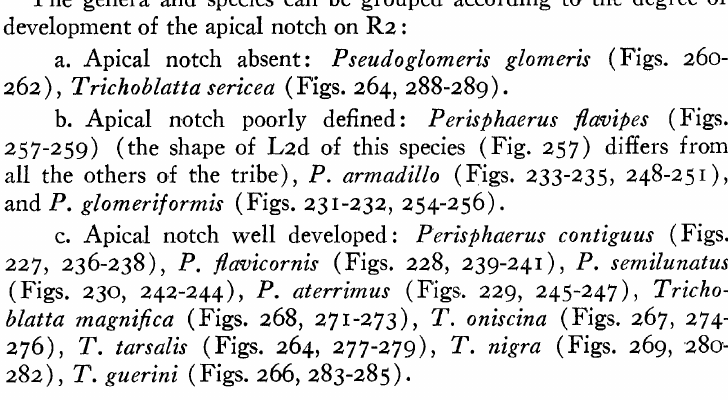
(Figs. :z3o, :z4:z-:z44), P. aterrimus (Figs.. :z:z9, :z45-:z47), Tricho- blatta magnifica (Figs. :68, :7I-:Z73), T. oniscina (Figs.. :z67,